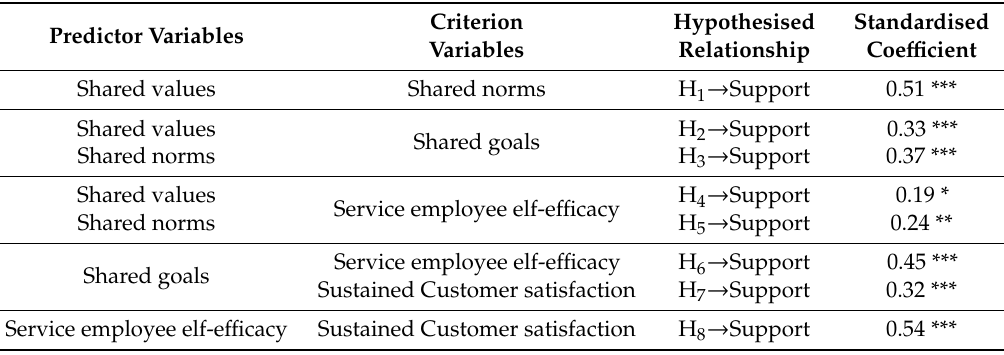
Table 5. Summary of SEM results for the proposed